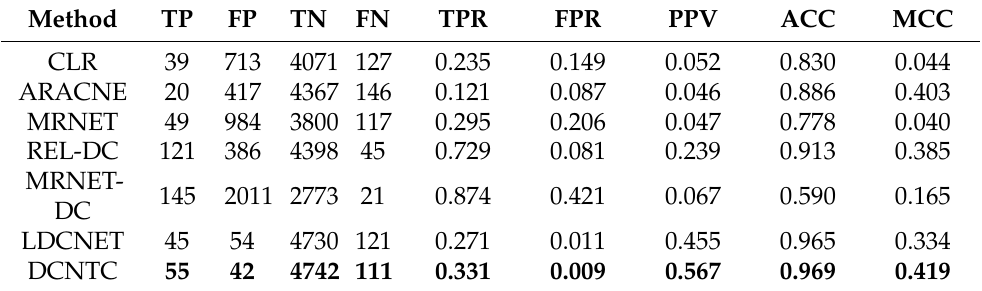
Table 3. Comparison of the performance of different methods for inferring a 100-gene network in